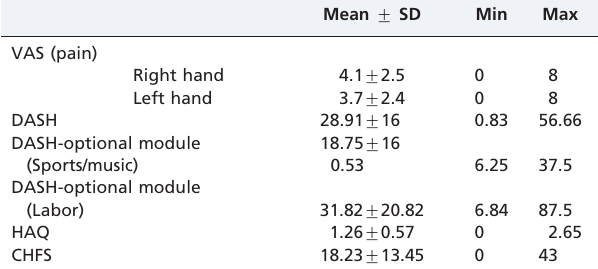
Table 3 - Scores on the instruments used in the evaluations.